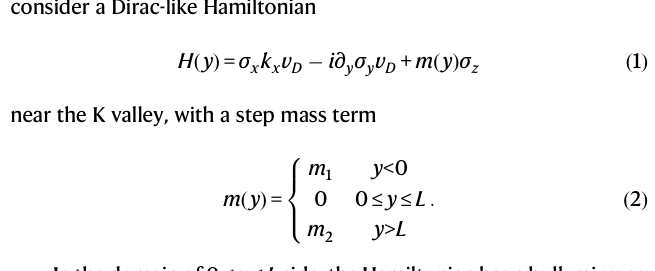
is in the x -direction and its width is 12 layers (each layer is direction. Left panel: pressure (colors) and energy fl ux (arrows) fi elds and the pressure phase (colors) fi eld of the CABS. The pseudogap (shadow region) is caused by the fi nite widthof the PCwaveguide. d The distribution ofDirac mass m along y-direction in the continuum model (see